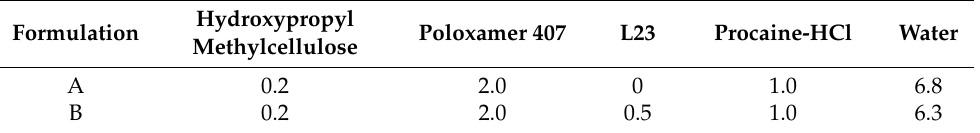
Table 1. Composition of the formulation * used